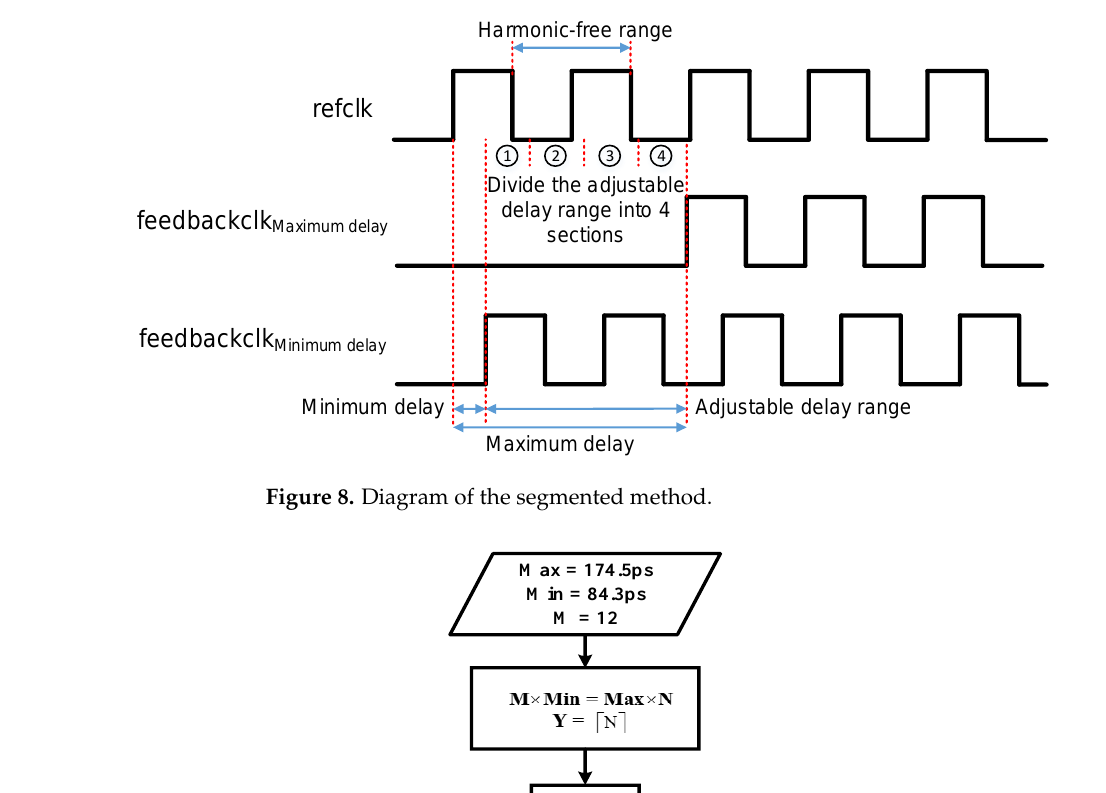
Figure 9. The process of coarse locking.